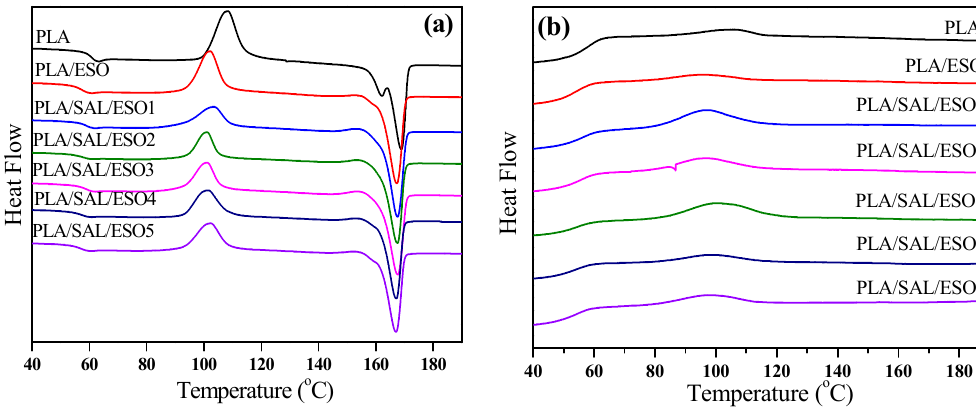
Figure 9. DSC melting ( a ) and crystallization ( b ) curves of PLA, PLA / ESO, and PLA / SAL composites.